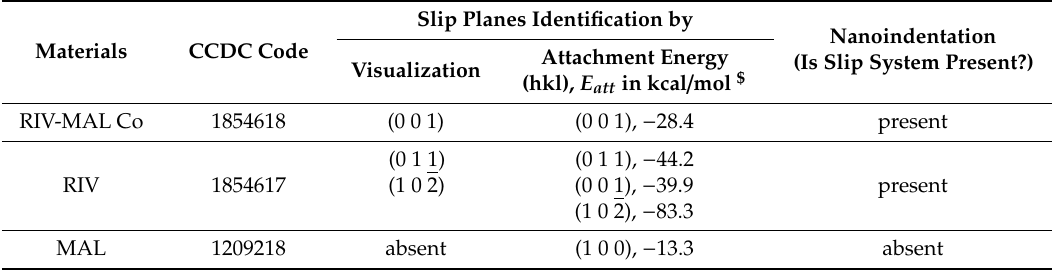
Table 3. Identification of slip plane using visualization, E att calculation and nanoindentation studies.